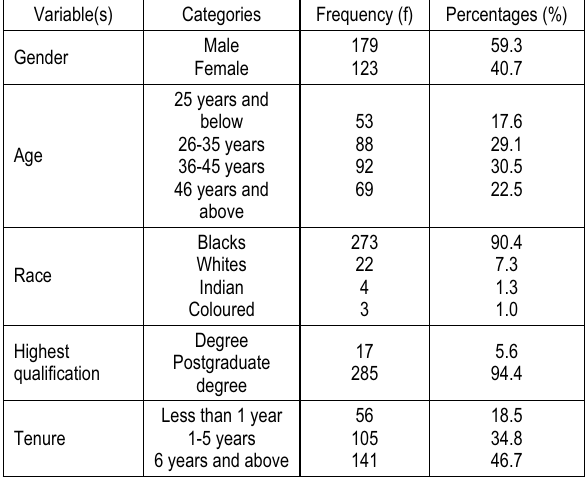
Table 1. Demographic variables: gender, age, race, highest qualification and tenure